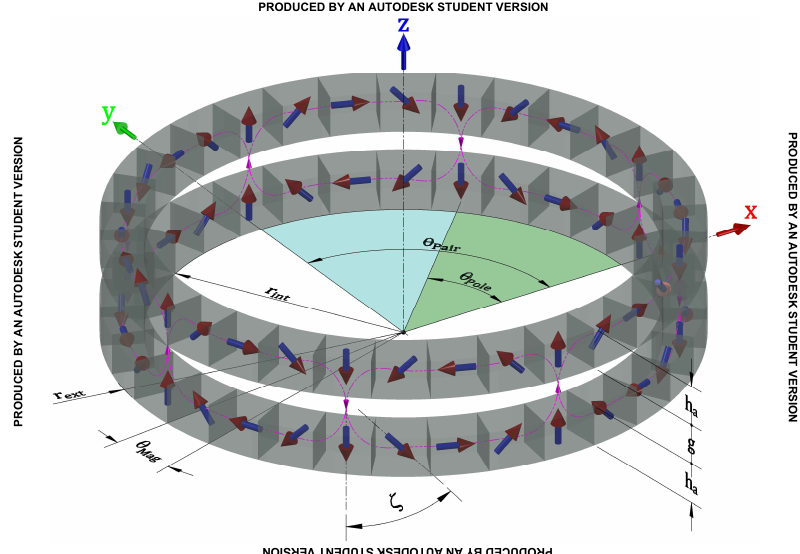
Figure 19. Axial Halbach array -based magnetic coupling with arched magnets, poles-pair p = 4, and Halbach stage H s = 3.